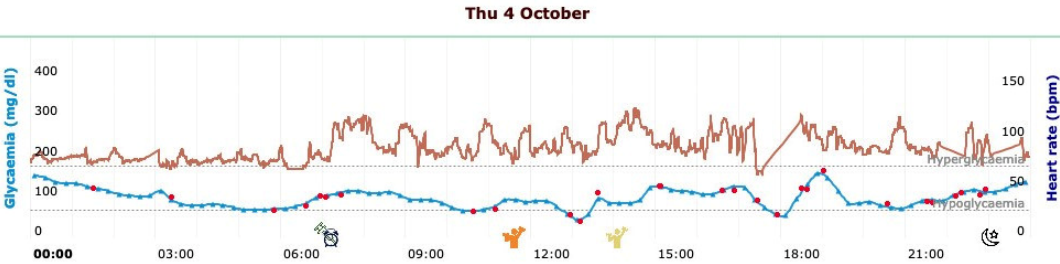
Figure 5. Daily profile, complemented by information on the subject’s sleep and workout.